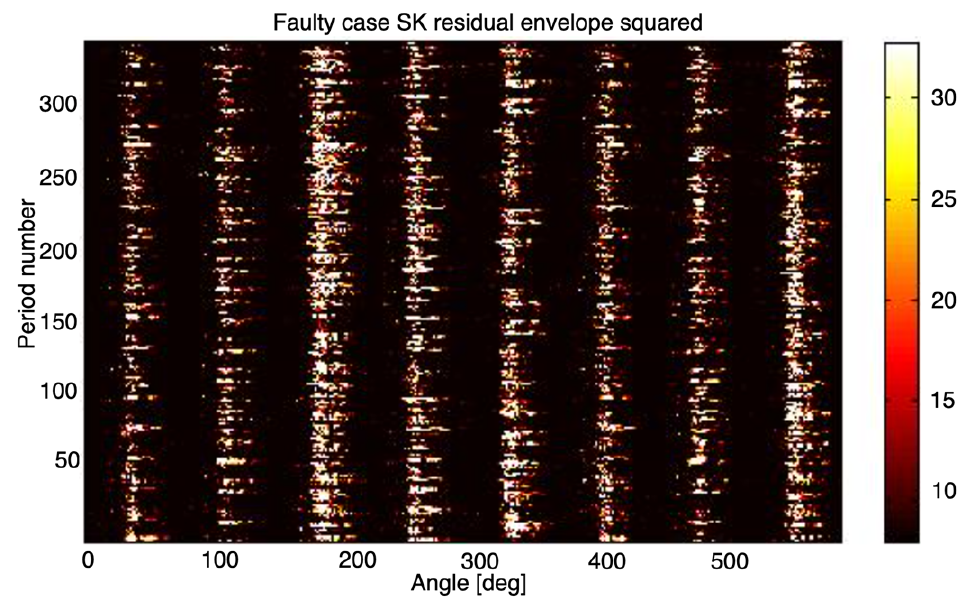
Figure 7. The aligned diagnostic features—squared envelope of the SK filtered signal.